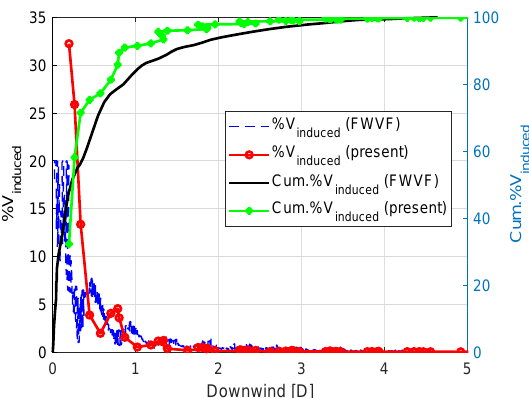
Figure 14. Wake induced velocity at the rotor for the NREL 5 MW turbine + ITI with surge, heave, and pitch for below-rated conditions.